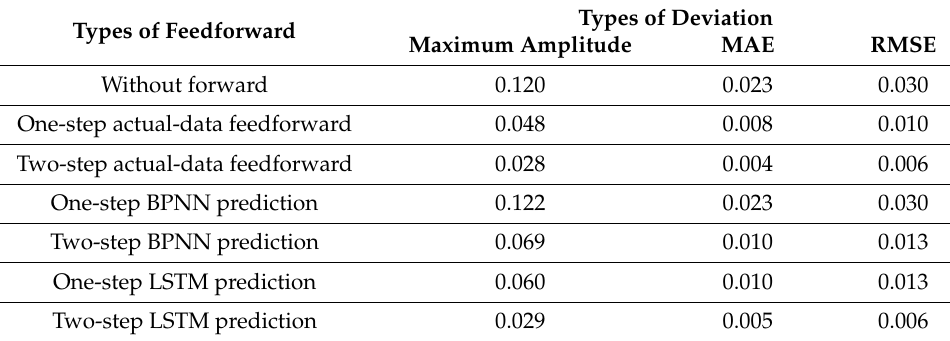
Table 6. Comparison of the deviation of different prediction